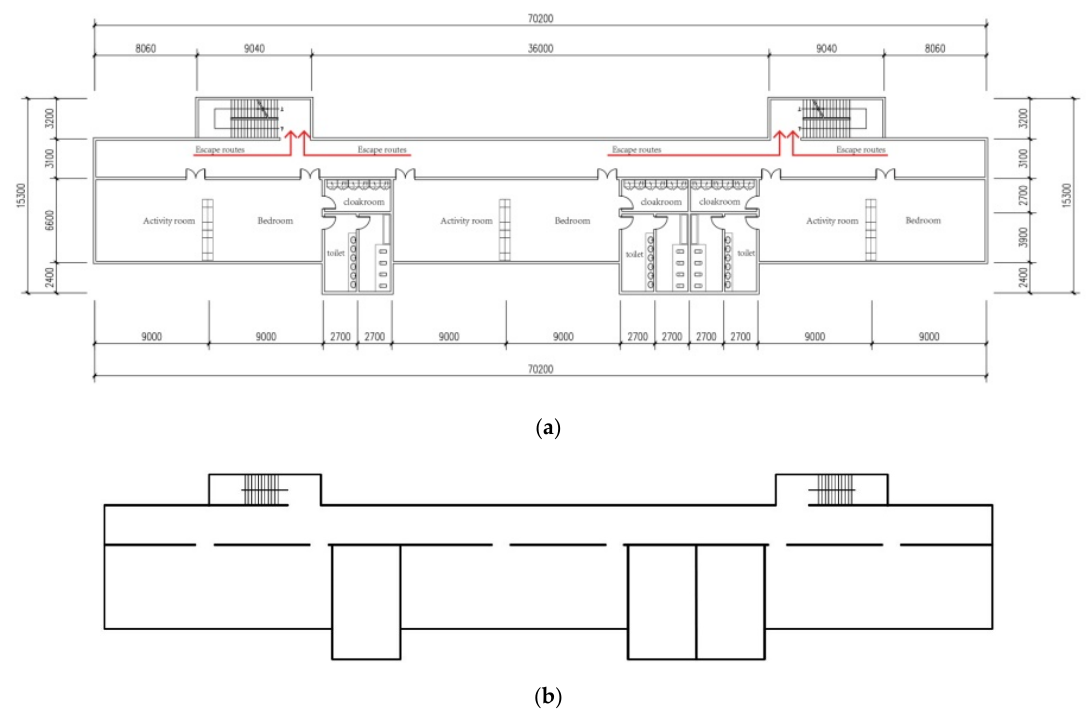
Figure 3. ( a ) Basic planar model; ( b ) simplified basic planar model.